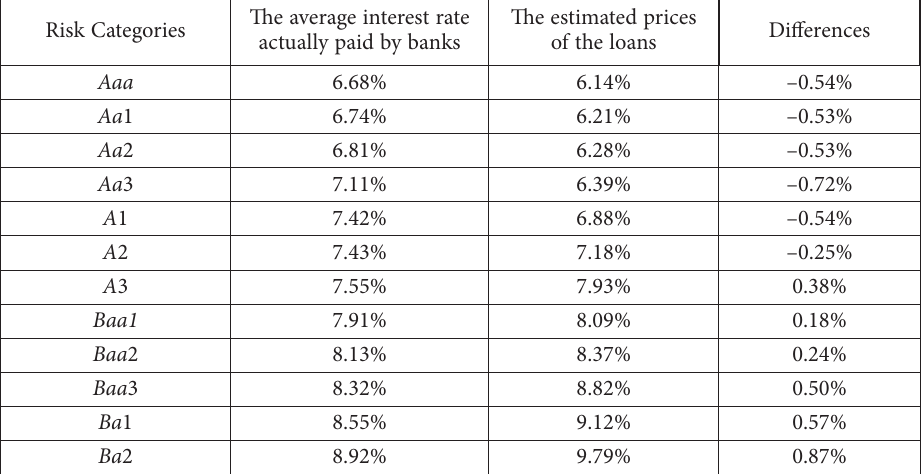
Table 2. RAROC and return rate of each rating category (source: own processing) Risk Categories